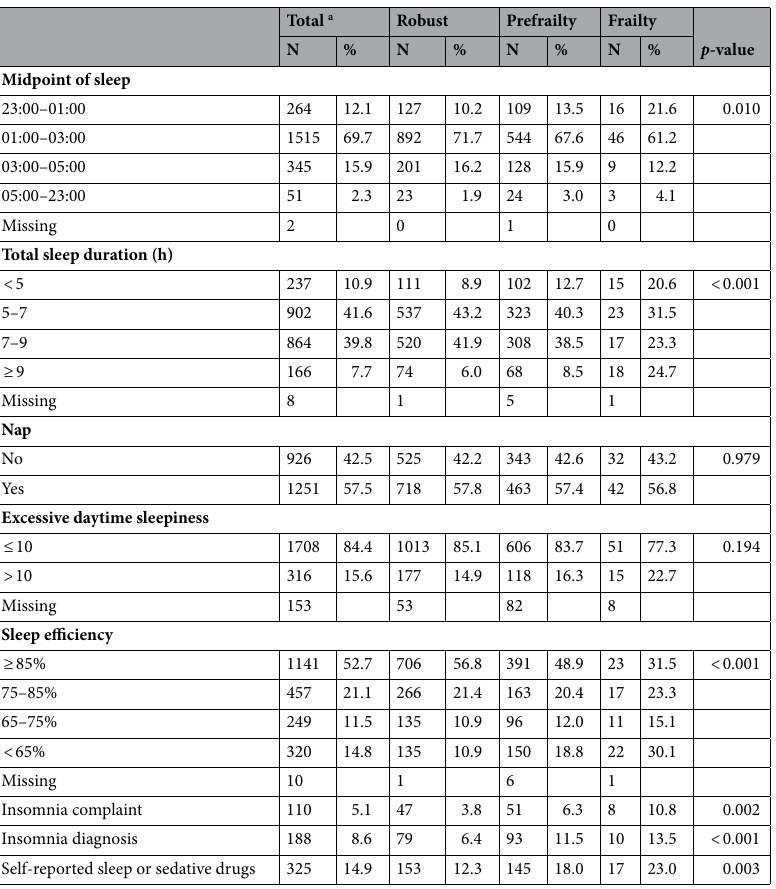
Table 2. Baseline sleep parameters for the study population. a Physical frailty status was missing for 54 participants